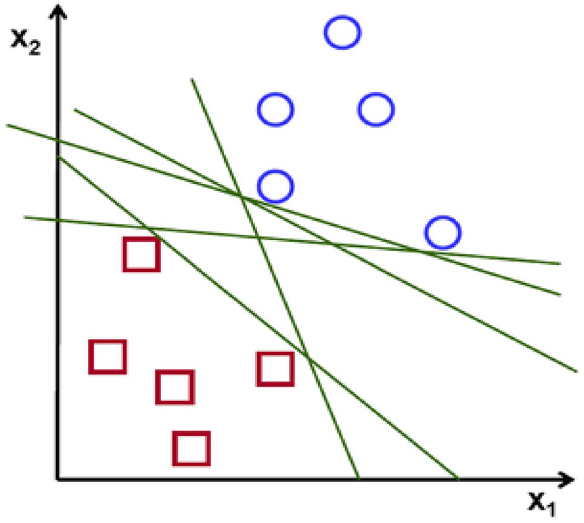
Figure 13. Depiction of two classes and various hyperplanes to provide optimal solution.